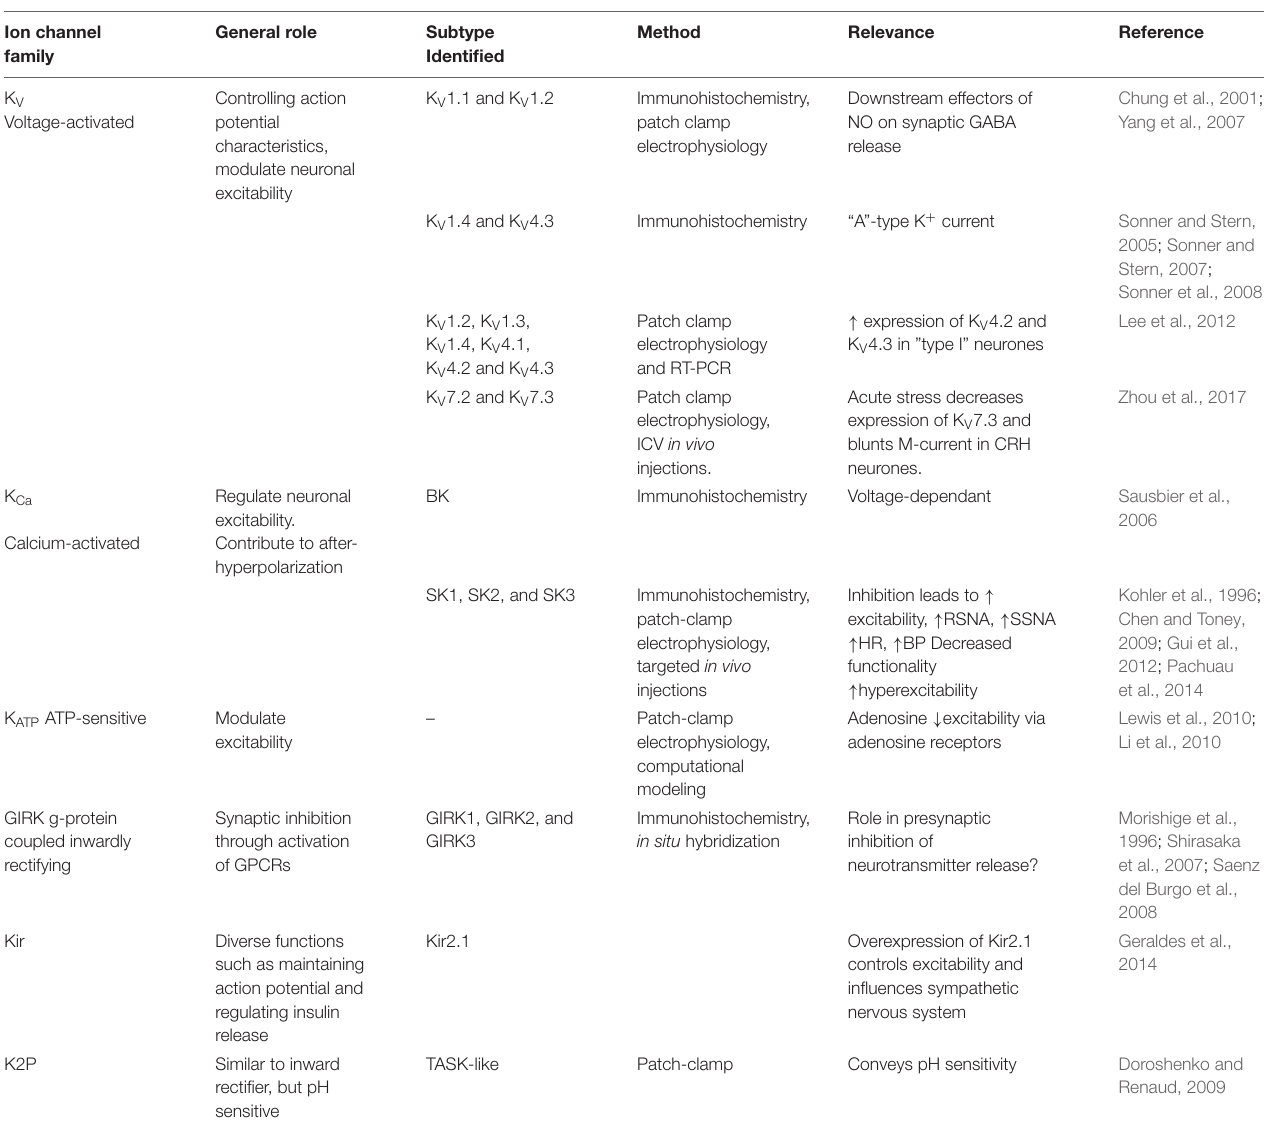
TABLE 3 | Potassium channels in the